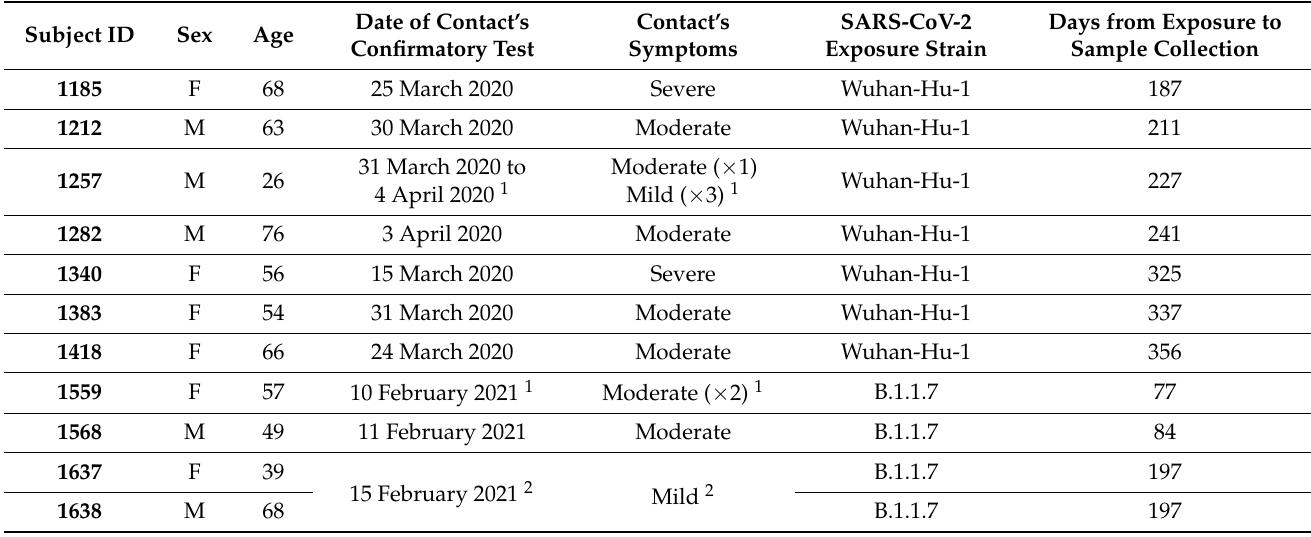
Table 1. Demographics of discordant cohort and details on exposure to SARS-CoV-2.